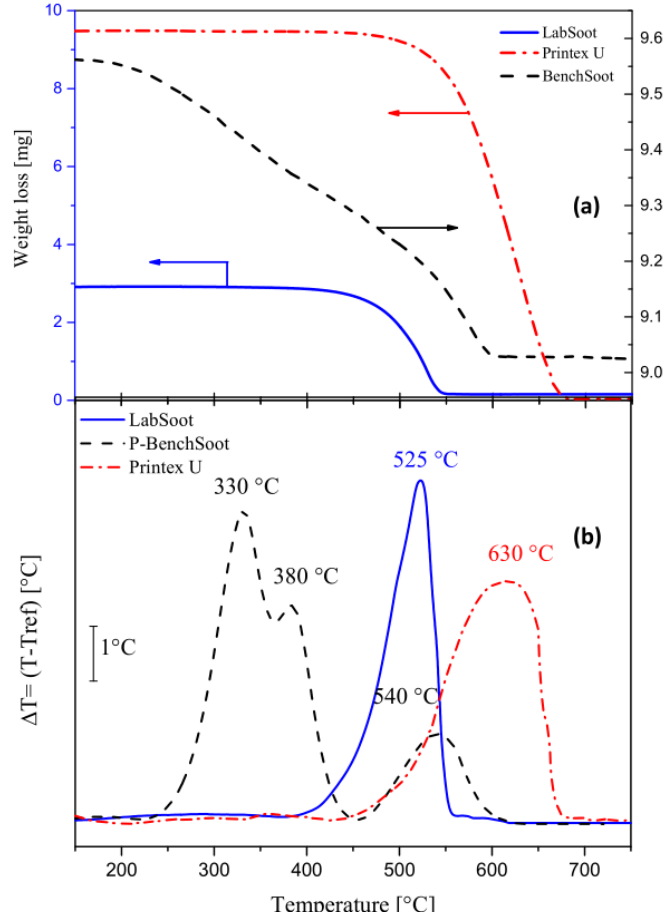
Figure 1. Thermogravimetric analyses: ( a ) TGA and ( b ) SDTA of bare LabSoot, bare Printex U and BenchSoot loaded on ceramic paper.